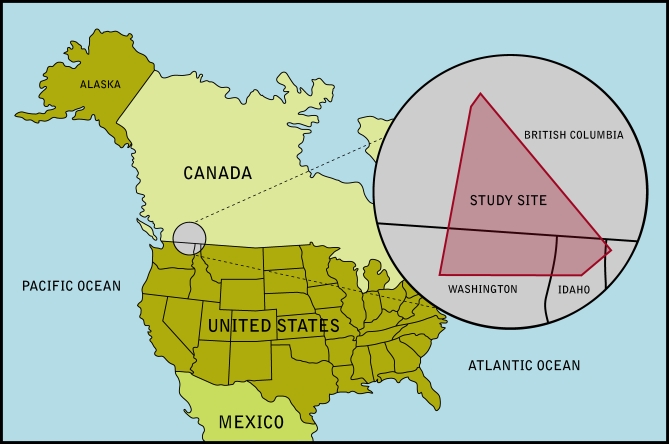
Studying Cougar Population Dynamics and Viability in the Selkirk MountainsResearchers with the Large Carnivore Conservation Laboratory at Washington State University captured and radio-collared 52 cougars living in the Selkirk Mountains (in northeastern Washington, northern Idaho, and southeastern British Columbia) and Colville National Forest (in northeastern Washington) to test the hypothesis that a growing cougar population was responsible for increased cougar–human conflicts. They found that heavy hunting of the population, implemented in part to reduce conflicts, may have actually exacerbated the problem.